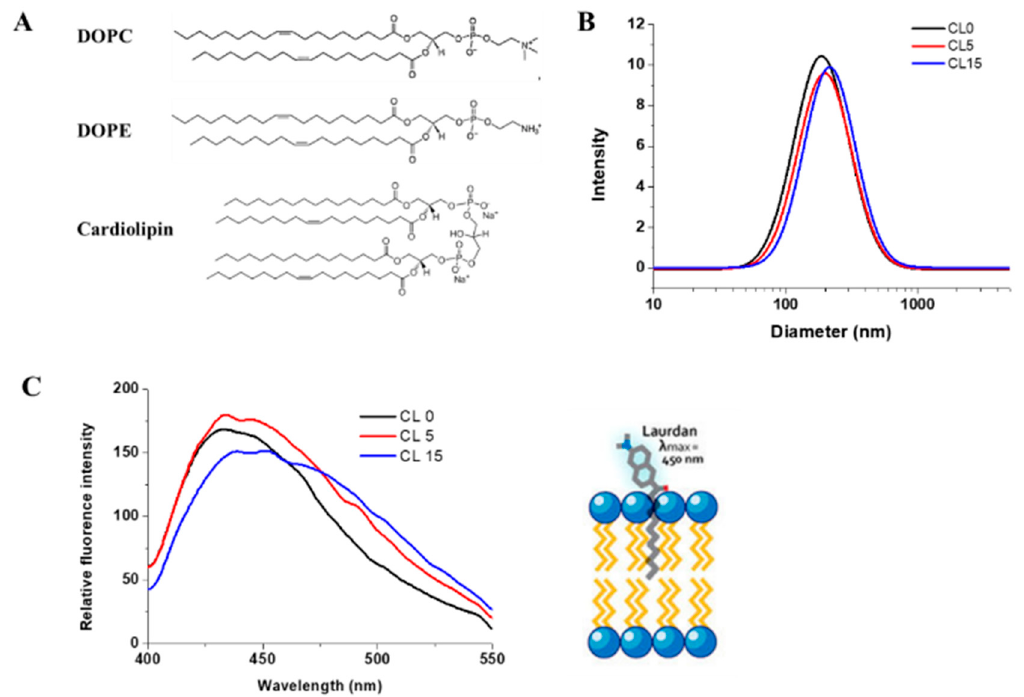
Figure 2. Characterization of liposomes. ( A ) Chemical structures of the lipids used for preparing liposomes. ( B ) Dynamic light scattering spectra of liposomes in the presence of 0%, 5%, and 15% cardiolipin, respectively. ( C ) Fluorescence spectra of Laurdan in each formulation and a schematic model representing the insertion of Laurdan in liposomes. Experiments were performed with 100 µ M lipid and 1 µ M Laurdan. Lines represent liposome formulations CL0 (black), CL5 (red), CL15 (blue) respectively.